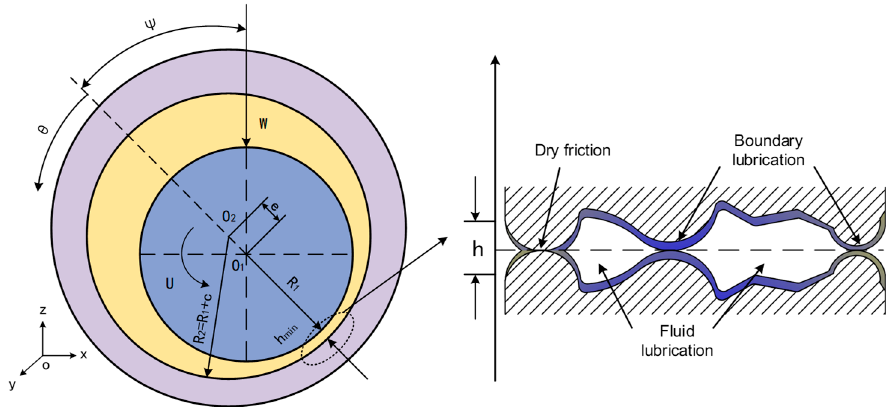
Figure 8. Model curved surface of boundary film strength.